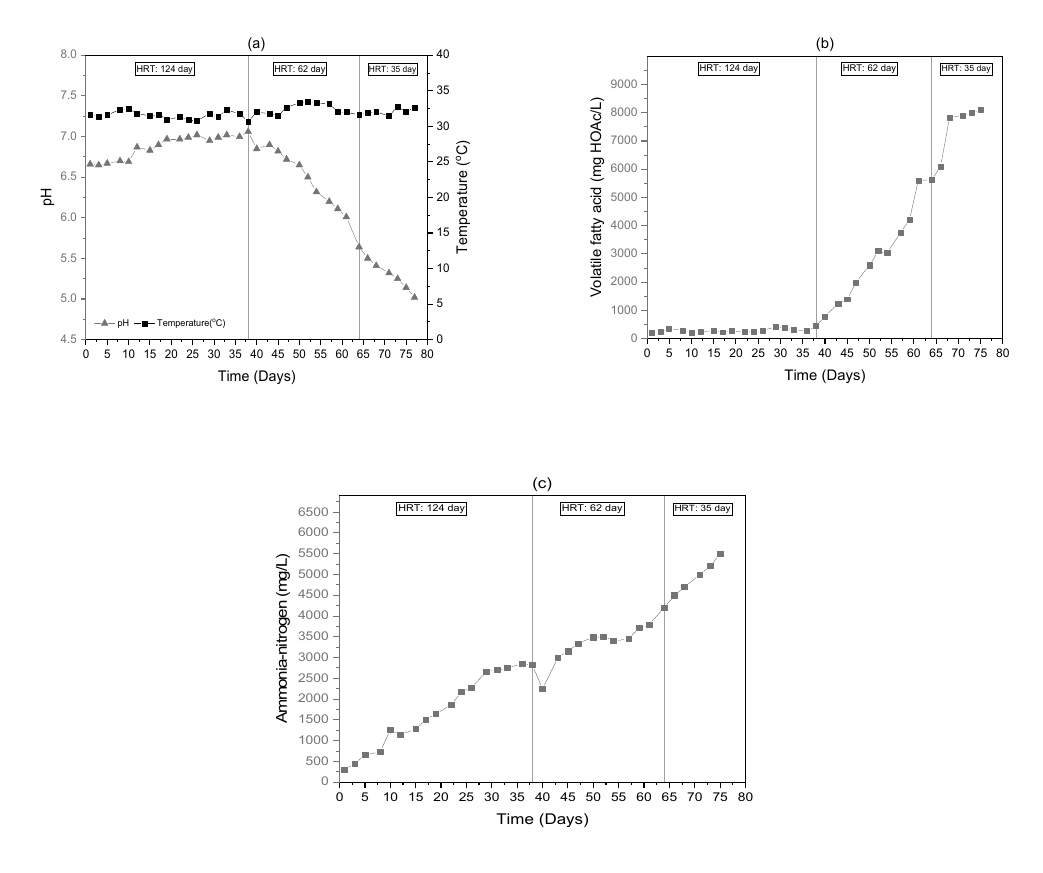
Figure 3. pH, volatile fatty acids, and ammonia-nitrogen concentration in different operating stages during anaerobic digestion of food waste. ( a ) pH value; ( b ) volatile fatty acid (VFA) concentration; ( c ) ammonia-nitrogen concentration.